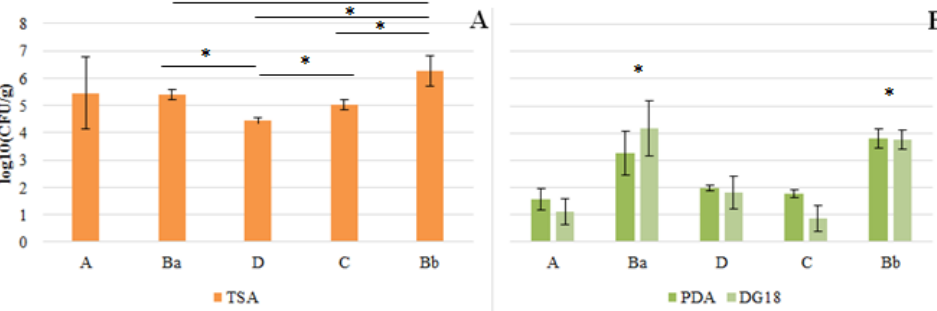
Figure 8. Bacterial (A) and fungal (B) Colony Forming Units (average ± standard deviation; n = 3) obtained by sampling the surface of earthen materials in situ. Fungal numerations for both Ba and Bb were significantly different from those for sites A, D and